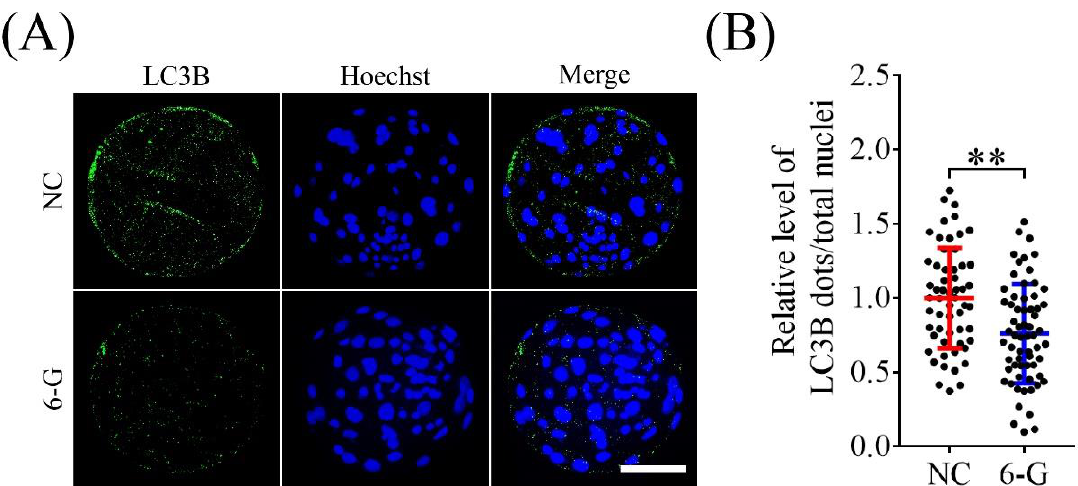
Figure 6. 6-Gingerol (6-G) treatment affects the autophagy levels in porcine early embryos. ( A ) Representative immunofluorescence images of microtubule-associated protein 1 light chain 3 beta (LC3B) in blastocysts. Bar = 100 μm. ( B ) Proportions of LC3B-positive puncta in blastocysts with or without 6-G treatment. R = 5. ** p < 0.01.